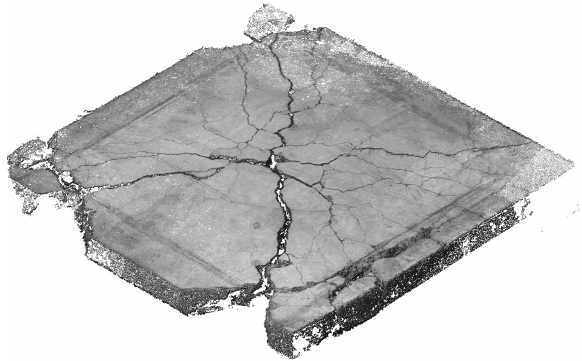
Figure 6. Point cloud of plate in shadow with G-419B.